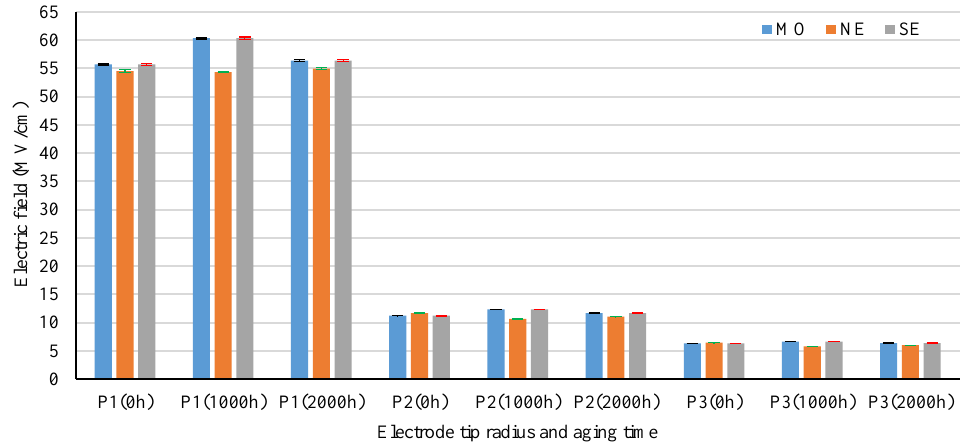
Figure 7. Electric field as a function of electrode tip and aging time.